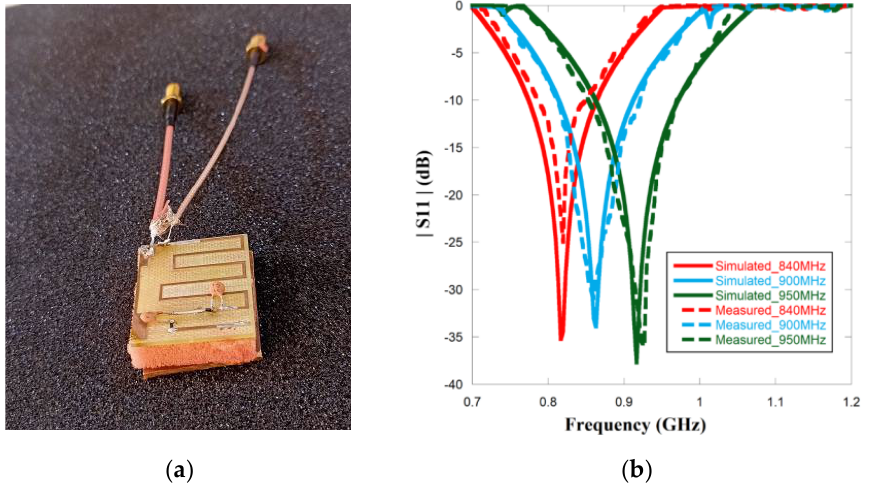
Figure 9. ( a ) Fabricated tag antenna with differential test fixture ( b ) | S 11| results of simulated and measured data .